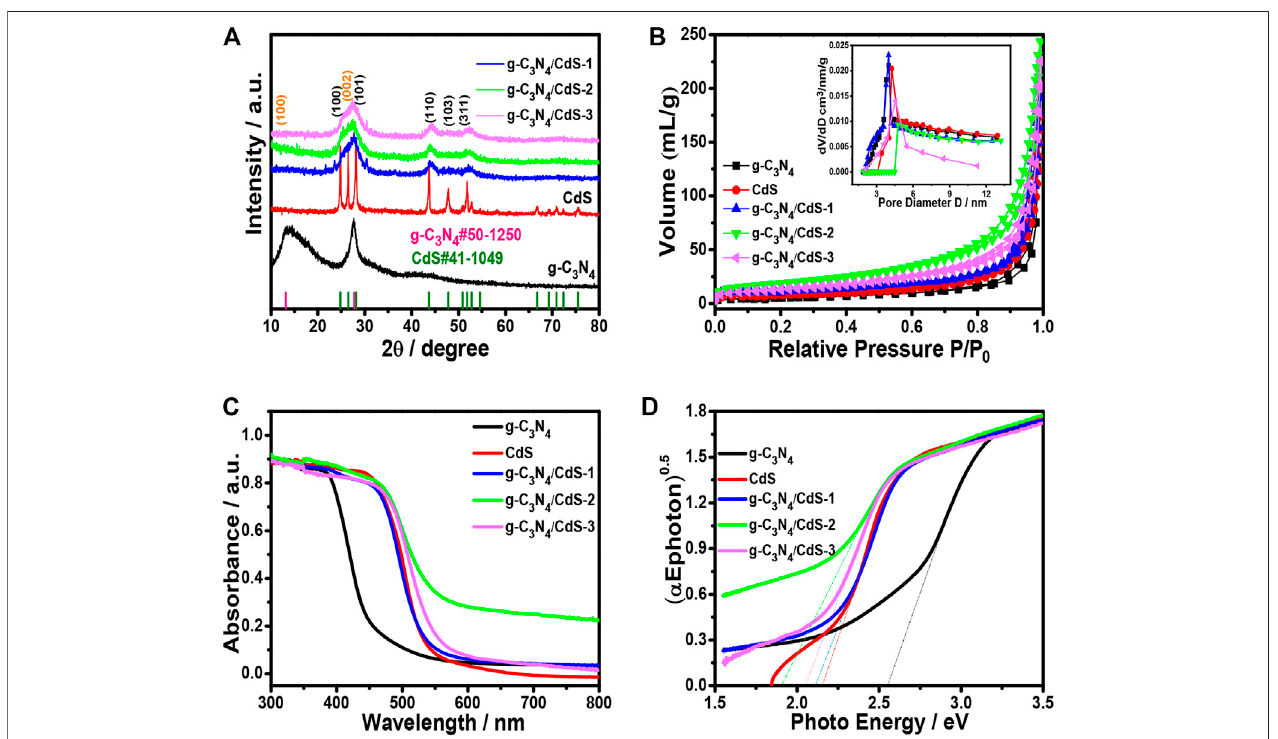
FIGURE 4 | Fully scanned XPS spectra of (A) g-C 3 N 4 , CdS, and g-C 3 N 4 /CdS; high-resolution XPS plots of (B) C 1 s, (C) Cd 3 days, and (D) S 2p.